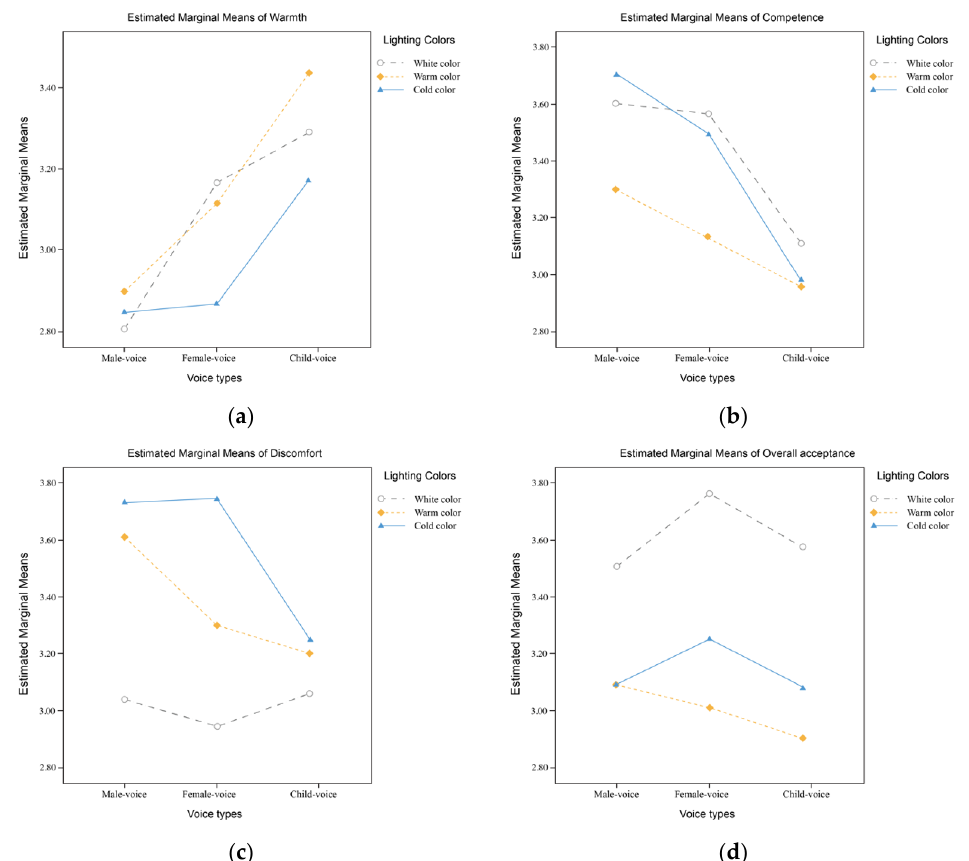
Figure 4. Effects of the interaction between robot voice type and lighting color on the participants’ ( a ) feeling of warmth, ( b ) feeling of competence, ( c ) feeling of discomfort, and ( d ) overall acceptance of the robot.